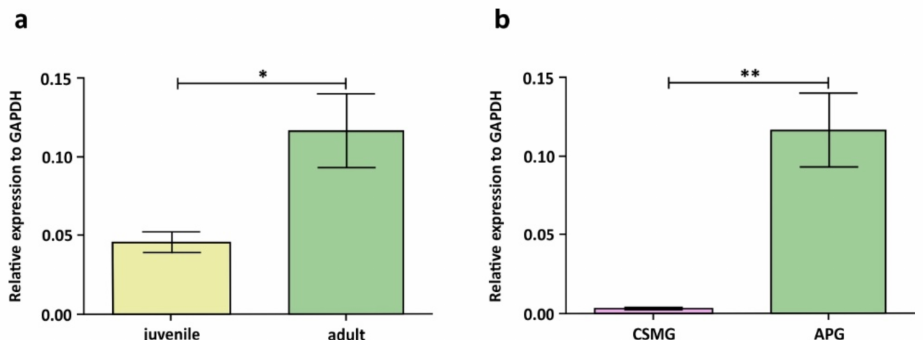
Figure 2. ( a ) Gene expression of androgen receptor (AR) in anterior pelvic ganglion (APG) tissue in 7-day-old (juvenile) and 180-day-old (adult) male pigs measured by quantitative real-time PCR (qPCR). Bars represent means and error bars correspond to SEM. * difference significant at p ≤ 0.05. ( b ) Gene expression of AR in APG and celiac-superior mesenteric ganglion (CSMG) tissue in the adult male pigs measured by qPCR. Bars represent means and error bars correspond to SEM. ** difference significant at p ≤ 0.01; Figure 2 is adapted from Kaleczyc et al. [31].